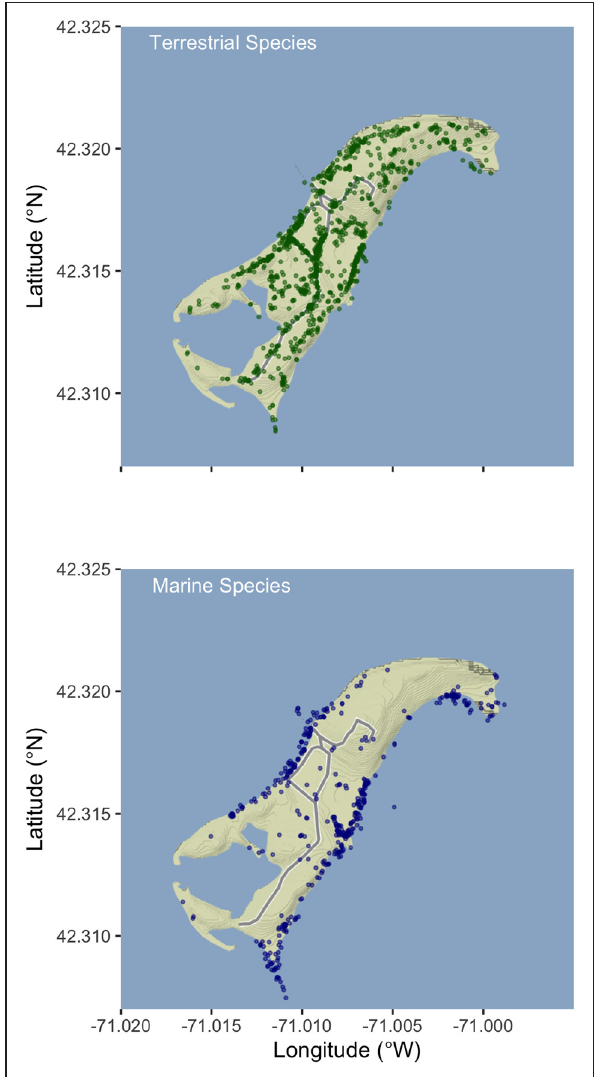
Figure 7 Location of student observations on Thompson Island, Boston Harbor, Massachusetts generally follows expectations for terrestrial species ( top panel ) found across the island, mostly along walking paths, whereas marine species were observed along the shoreline ( bottom panel ). A few of the marine observations appear in deeper water indicating larger location errors. Some made on land are likely to be shells or carapaces. Those at the lowest latitudes (< 42.31°N) may represent observations made at low tide.